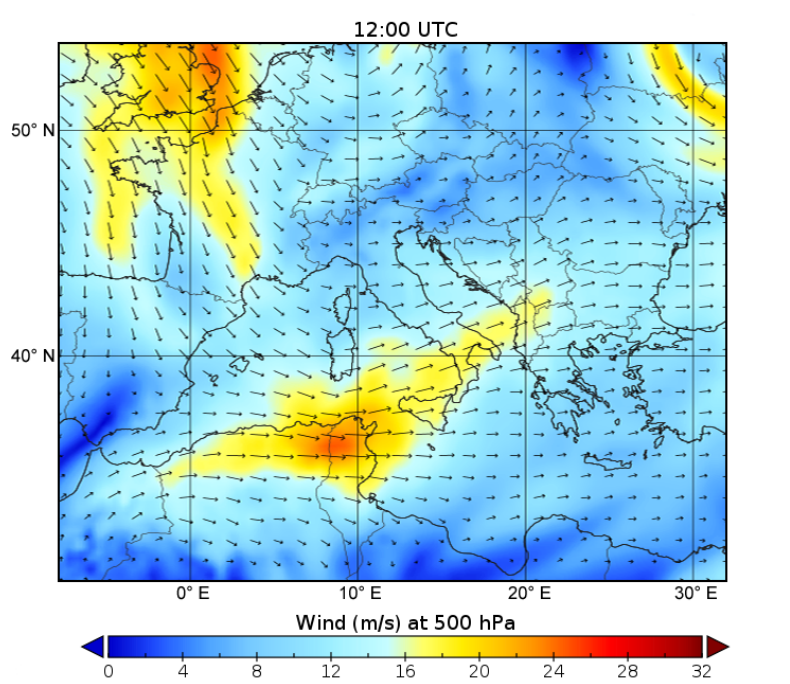
Figure 9. Divergence in altitude near Sicily. Flow from west to northwest to the south of the island, and from the southwest just to the north.